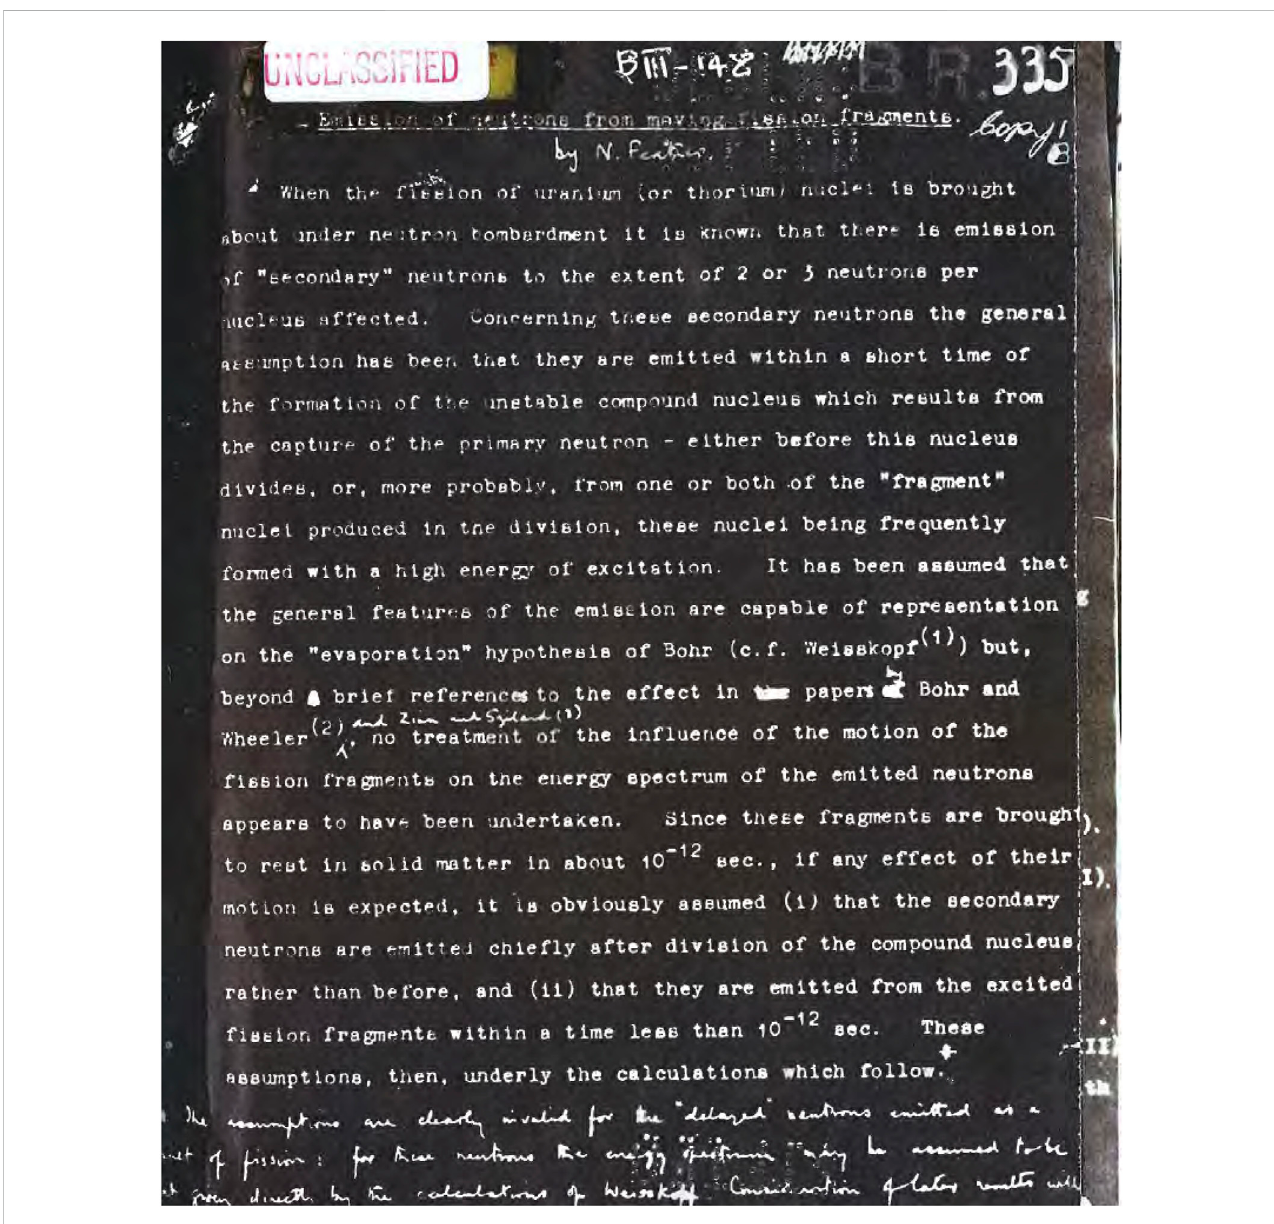
AnextractfromNormanFeather ’ sPFNSreport — U.S.AtomicEnergyCommissionDocumentNo.BR335A,1942alsoknownasBritishMissionreportBM- 148, 1942, Cambridge